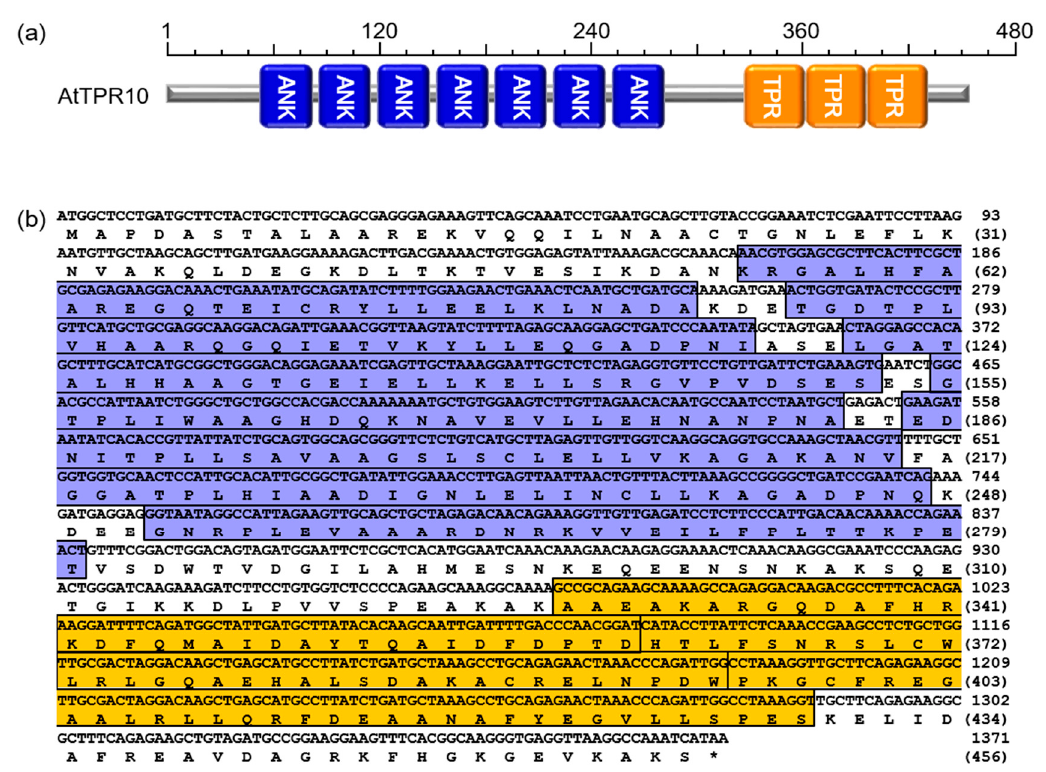
Figure 2. Typical features of AtTPR10 . ( a ) Schematic representation of AtTPR10 structure containing seven N-terminal ankyrin (ANK) repeats and three C-terminal TPR repeats. ( b ) Nucleotide and amino acid sequences of AtTPR10. The ANK repeats are indicated in blue, while the TPR domains are indicated in orange. Asterisk (*) indicates the stop codon.